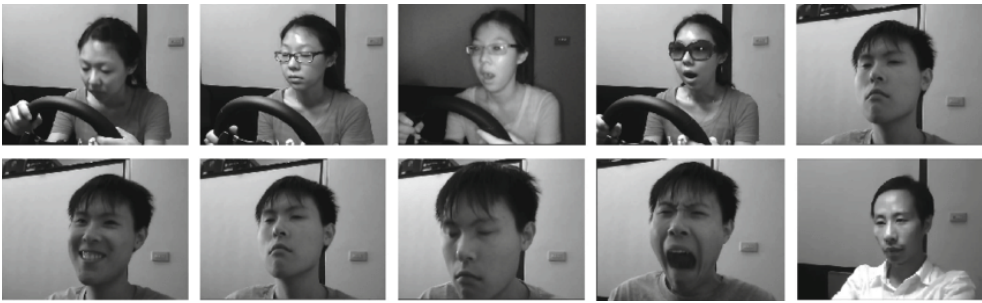
Figure 11. Sample snapshots of the public NTHU-DDD dataset [36].